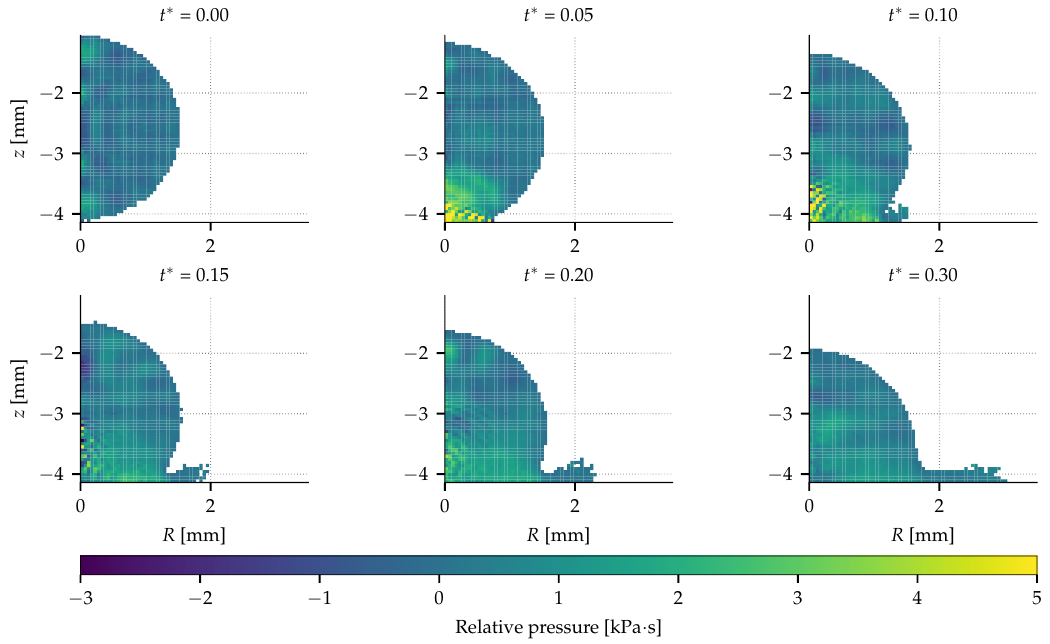
Figure 4. Axisymmetric mean of the pressure for Case